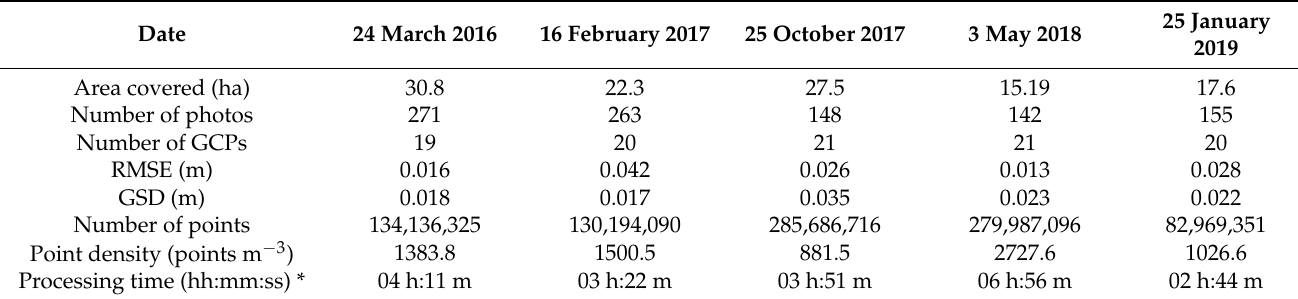
Table 2. Characteristics of the surveys carried out. GSD: ground sampling distance, GCPs: ground control points, RMSE: root mean square